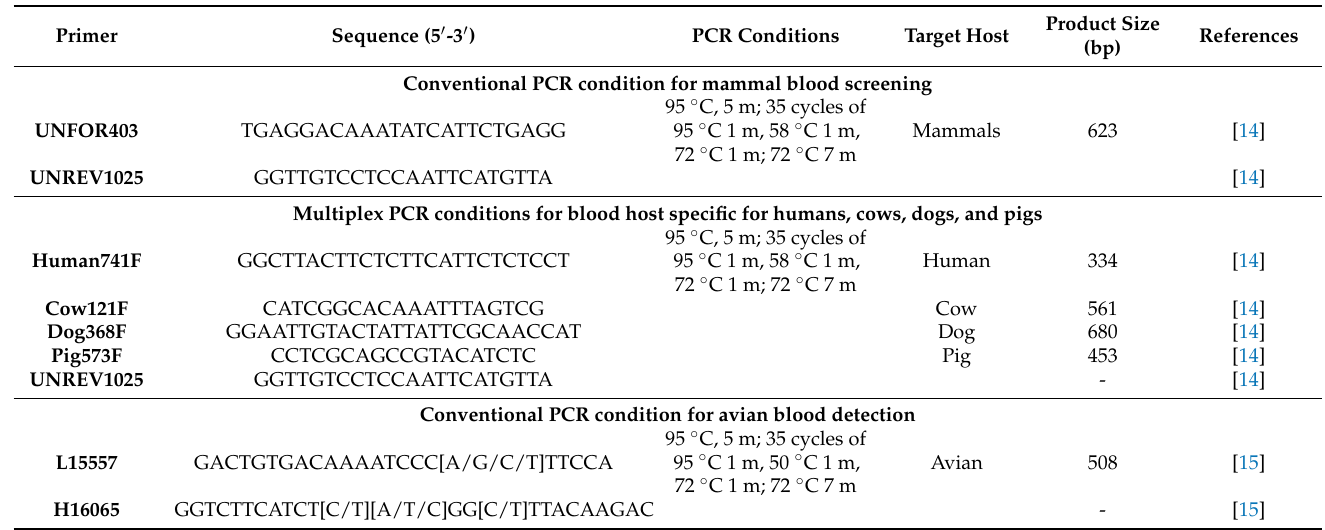
Table 1. Primer sequences and PCR conditions for the cytochrome b-based polymerase chain reaction blood meal identification